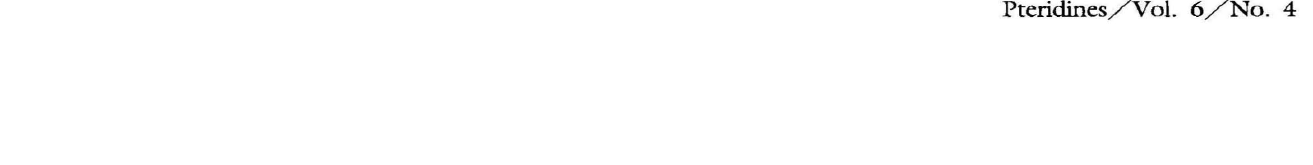
Figure 4. Effects of pretreatment with nornifensine on 6R-BH..-induced increases in DA levels in striatal di alysates. After DA levels in striatal dialysates reached a steady state, various doses of nomifensine (20 mg/kg, filled triangles; 100 mg/kg, filled squares; 200 mg/kg, filled diamonds) were injected intraperitoneally. Sixty minutes after the injection of 100 mg/kg of nornifensine, 6R-BIL was added to the perfusion fluid at a final con centration of 1 mM (open diamonds) during a 60-min period as indicated by a bar. Empty circles represent the control group which was i.p.injected with saline alone. Each value is the mean ± SEM of four